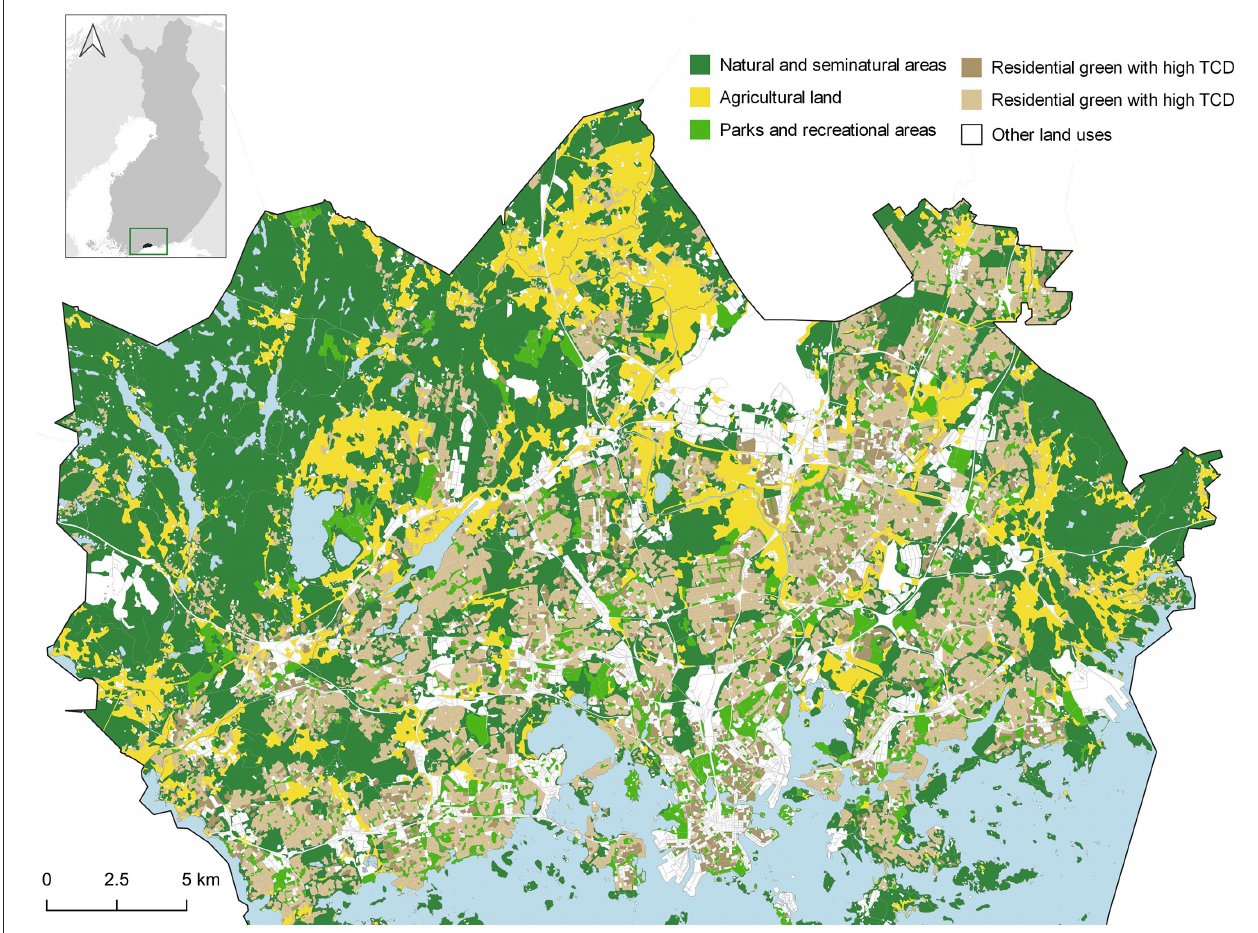
FIGURE 1 | Map of the study area (Helsinki Metropolitan Area) and green infrastructure types used in the analysis.